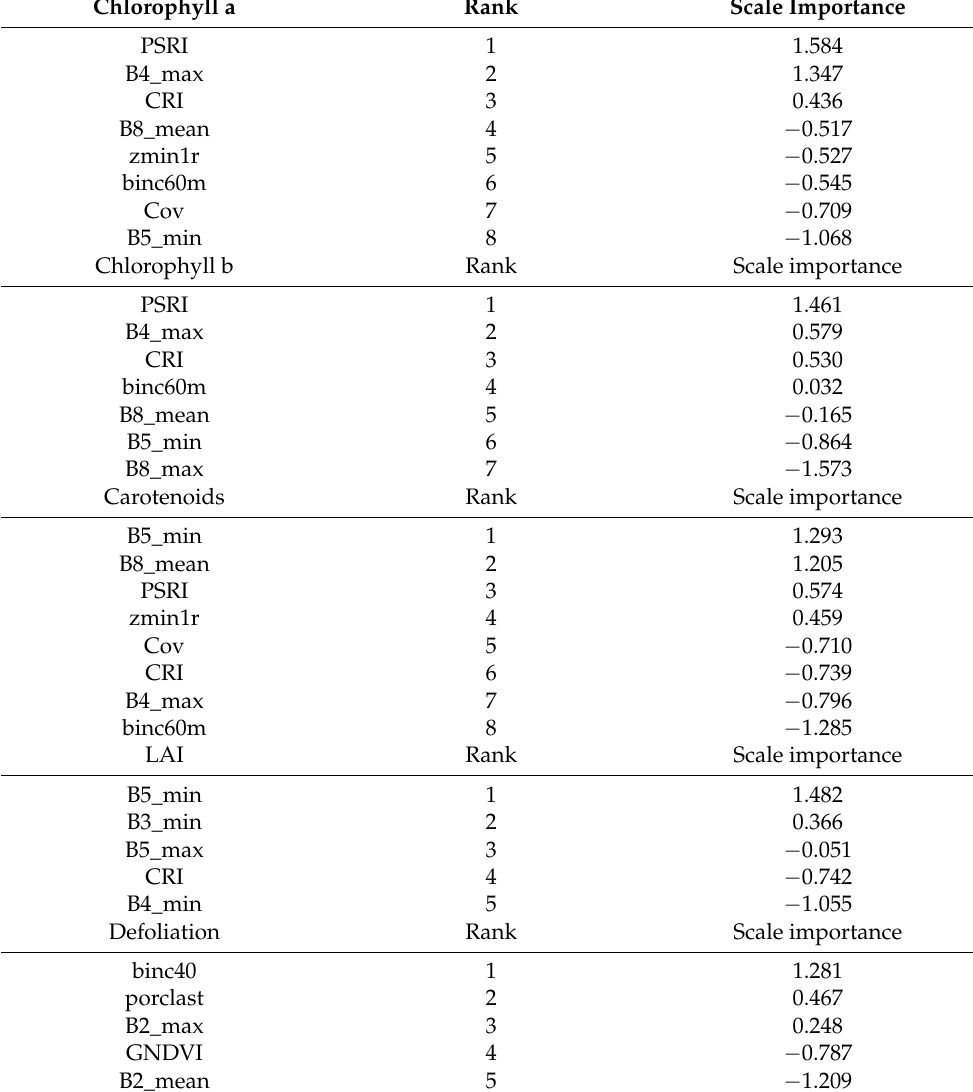
Table 5. Variable importance for the selected predictors used as inputs for random forest classification of defoliation and for k-NN modeling using random forest distance for LAI, pigments content, and random forest modeling for defoliation in Pinus sylvestris plantations in Southern Spain. Importance values have been centered and scaled by subtracting the mean value and dividing by its standard deviation. For each tree crown, maximum values in the band 8 of the WorldView2 image (B8_max), mean values in the tree crown in the band 2 (B2_mean), mean values in the band 4 (B4_mean), GNDVI index (GNDVI), percentage of first returns above the 2 m (cov), bincentil 60 (binc60m), mean values in the tree crown in the band 8 (B8_mean), CRI index (CRI), maximum values in the band 5 (B5_max), minimum height of the first returns (zmin1r), minimum values in the band 5 (B5_min), maximum values in the band 2 (B2_max), minimum values in the band 3 (B3_min), percentage of last returns (porclast), maximum values in the band 4 (B4_max), bincentil 40 (binc40), PSRI index (PSRI) were